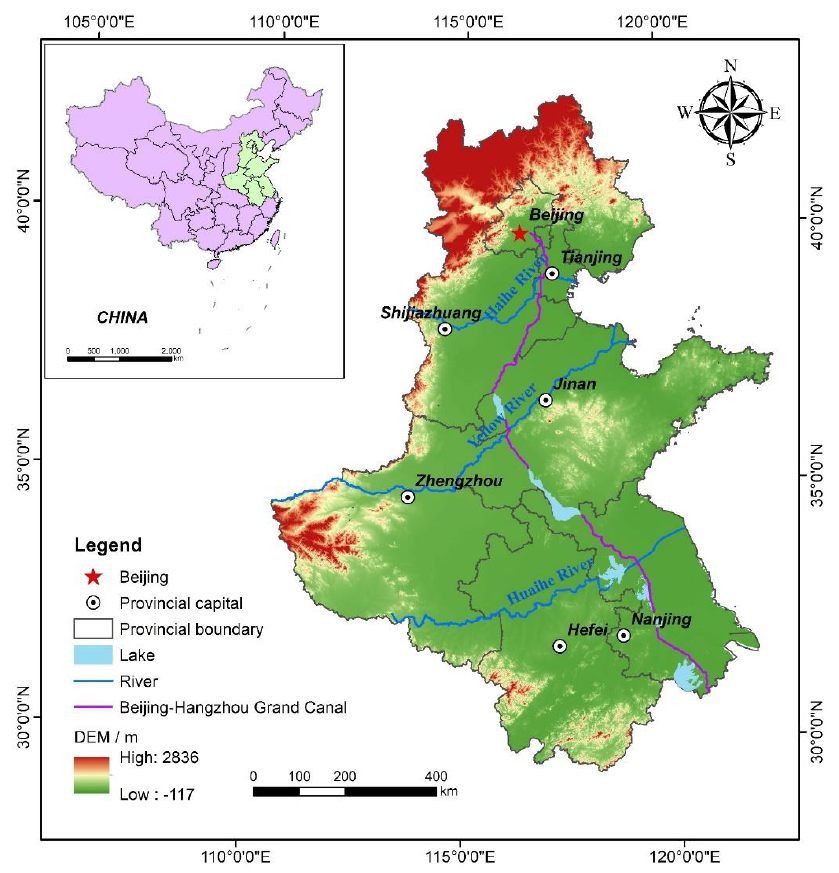
Figure 2. The geographical location of the North China Plain Area.